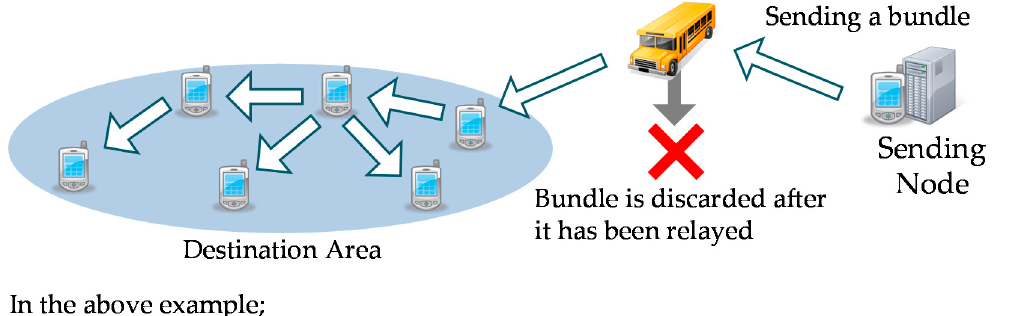
Figure 23. How to measure the number of copies.